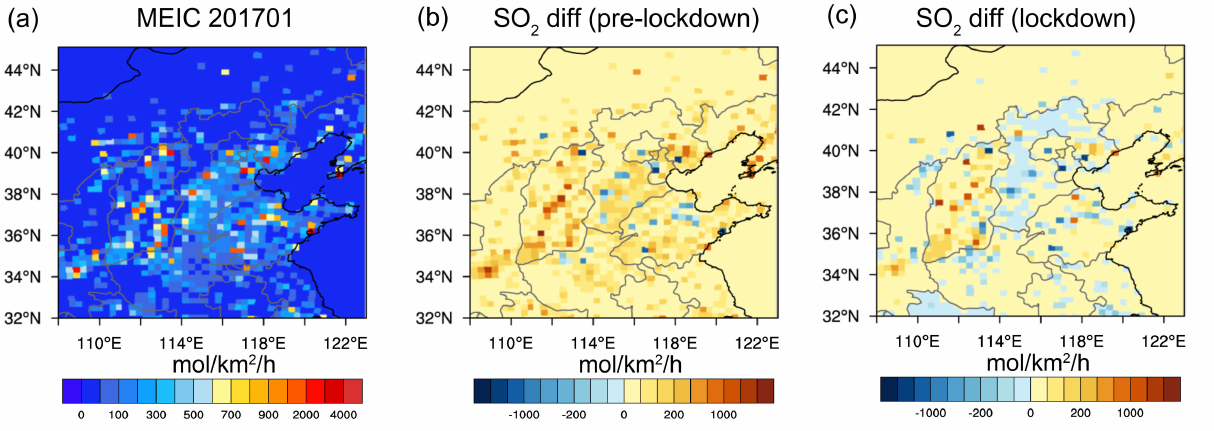
Figure 3. Spatial distribution of SO 2 emission in grids for ( a ) MEIC inventory in January 2017, the differences between the average optimized inventory and MEIC inventory during ( b ) the pre- lockdown period and ( c ) the lockdown period (units: mol/km 2